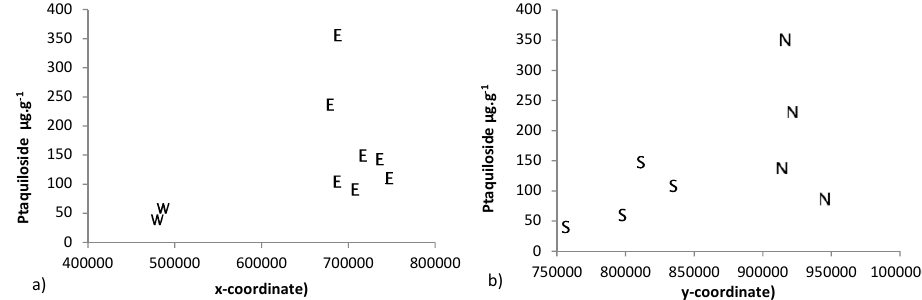
Figure 5. Scatterplots of ptaquiloside concentrations (µg·g − 1 ) versus ( a ) x and ( b ) y coordinates